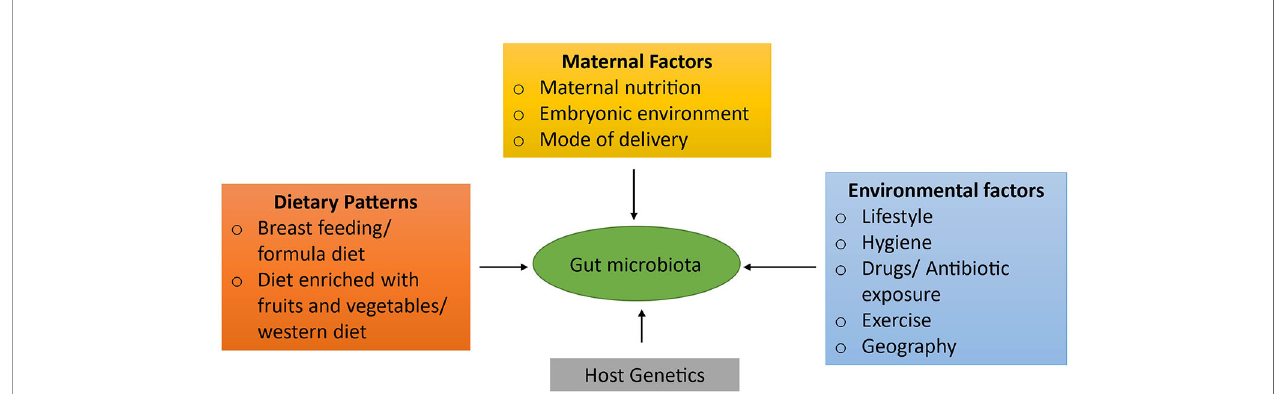
intake, infections, life style patterns, migration to a different location,